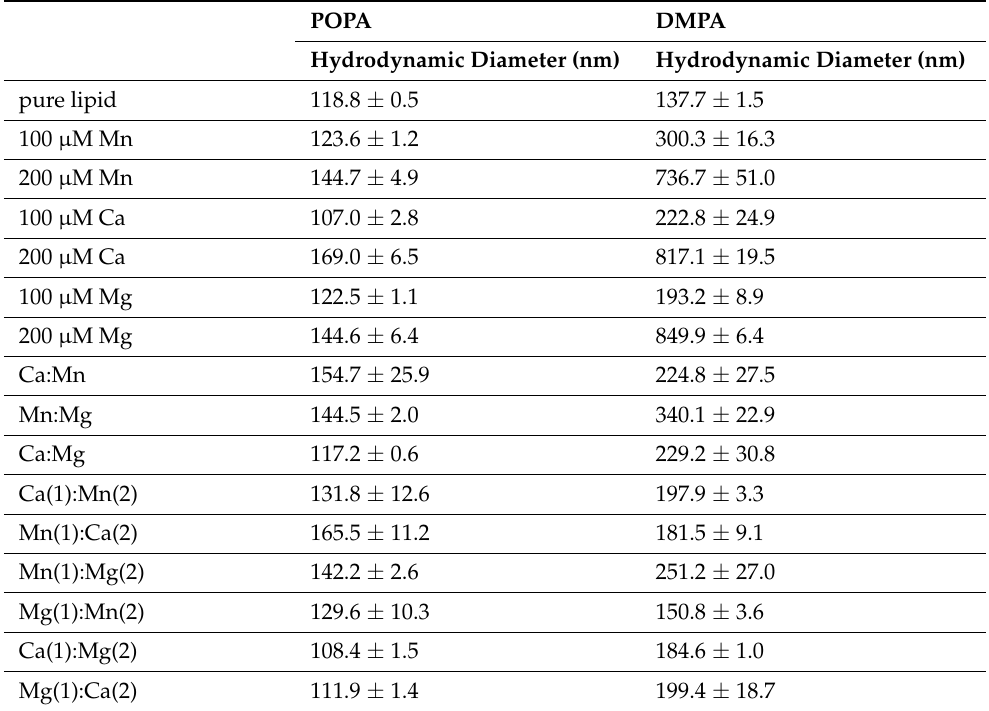
Table 4. Tabulated hydrodynamic diameter of POPA and DMPA with Mn, Ca, Mg and metal mixtures. POPA DMPA Hydrodynamic Diameter